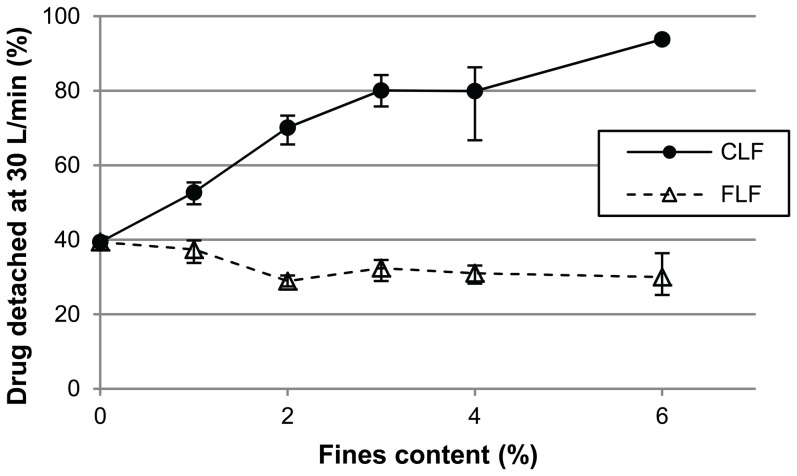
Drug detachment of 4% budesonide mixtures at 30 L/min as a function of added fines content.FLF =  fine lactose fines; CLF =  coarse lactose fines. Error bars represent maximum and minimum values measured (n = 5).